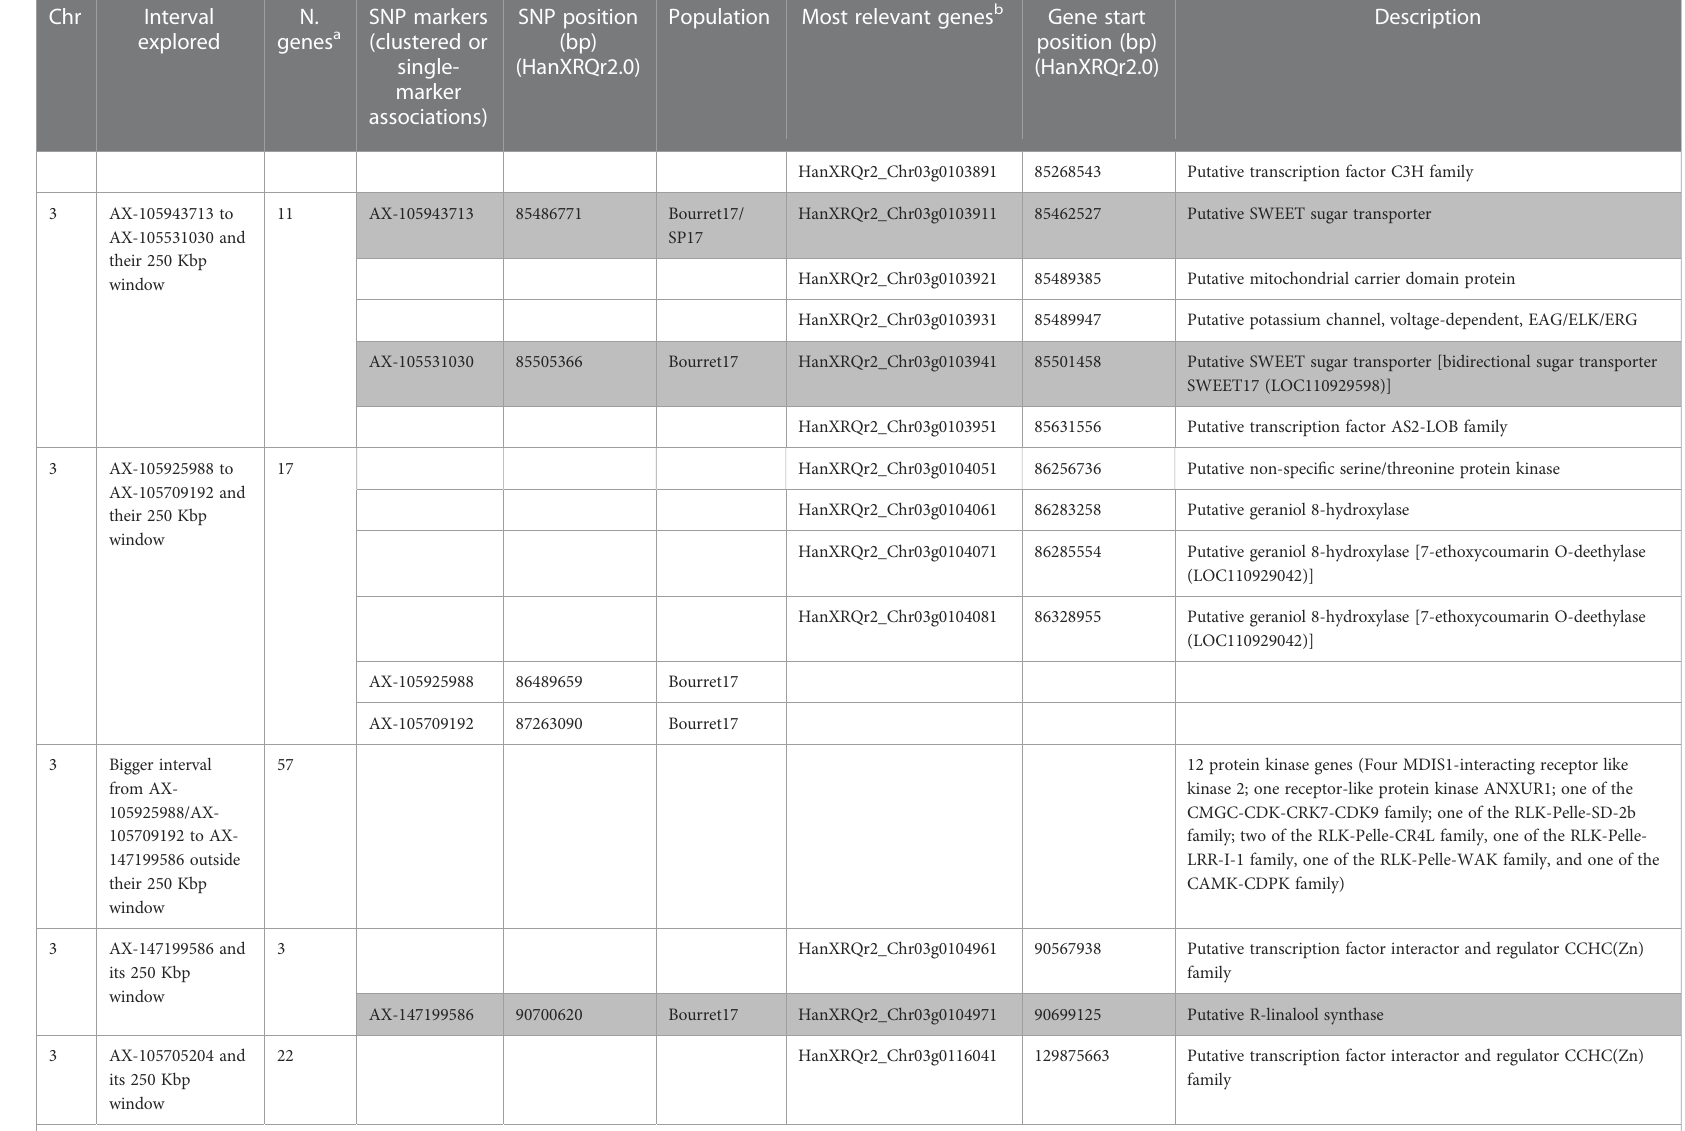
TABLE 6 Summary of the most relevant genes identi fi ed as associated to signi fi cant marker trait associations (detailed information in Table S2 ).